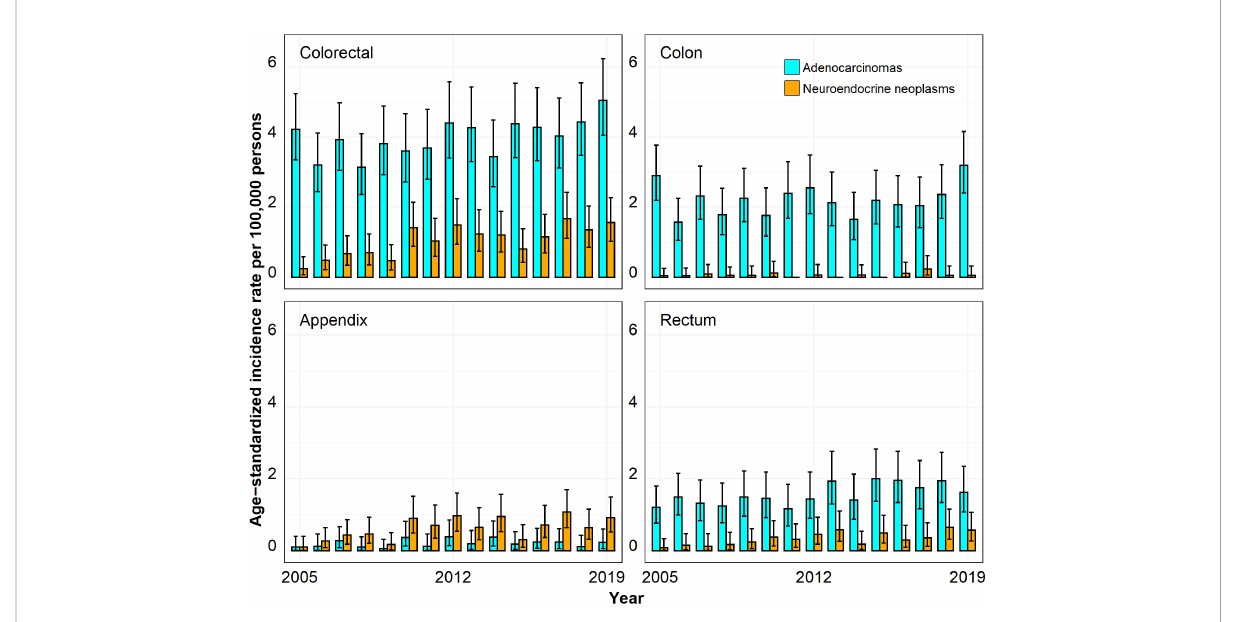
FIGURE 2 Annual age-standardized incidence rates per 100,000 persons for the age group 30 – 39 years by anatomic site and histological subgroup in Bavaria, 2005 – 2019. Error bars show 95% con fi dence intervals.